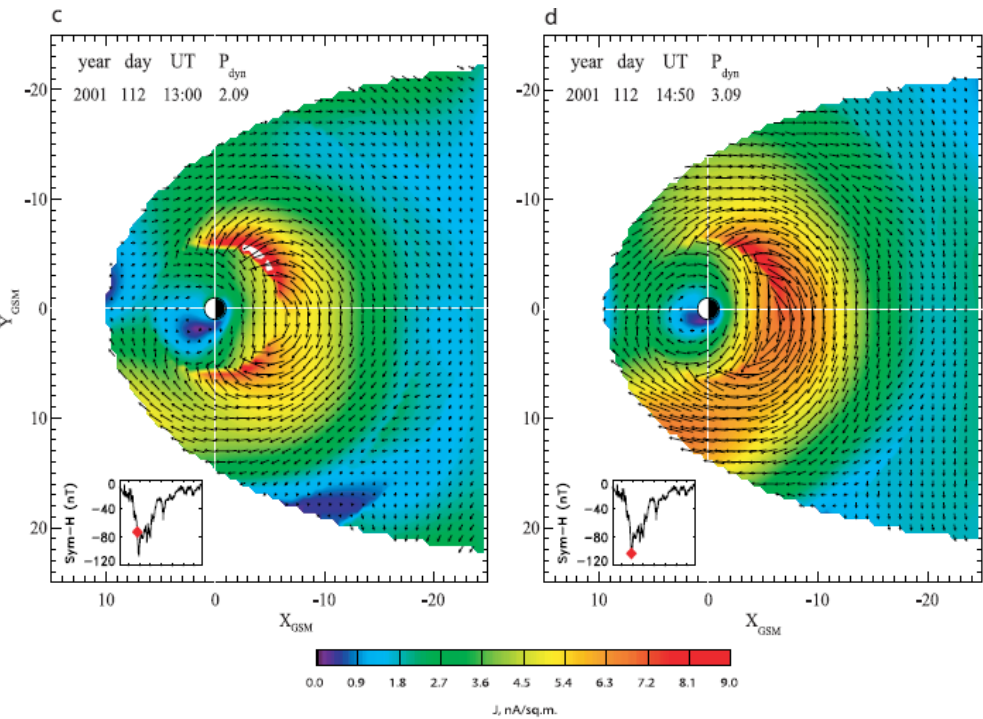
Figure 14. Modeled equatorial current density during the April 2001 storm main phase (Fig. 4c and d from Sitnov et al., 2008).